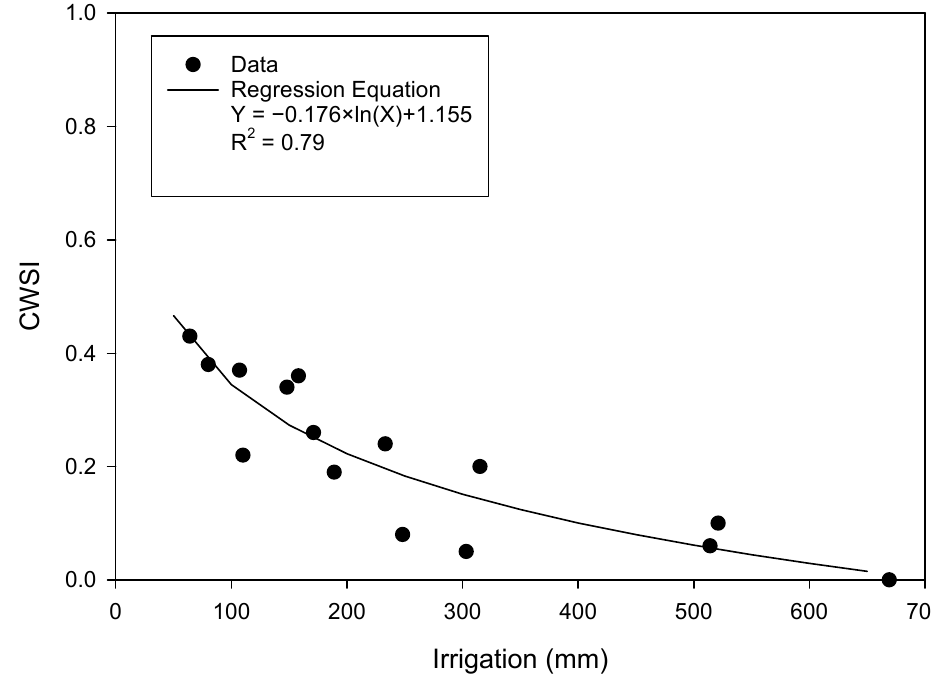
Figure 7. Relationship between the seasonal irrigation applied and seasonal average daily crop water stress index ( CWSI ) for Malbec over the 5-year study at the experimental site.